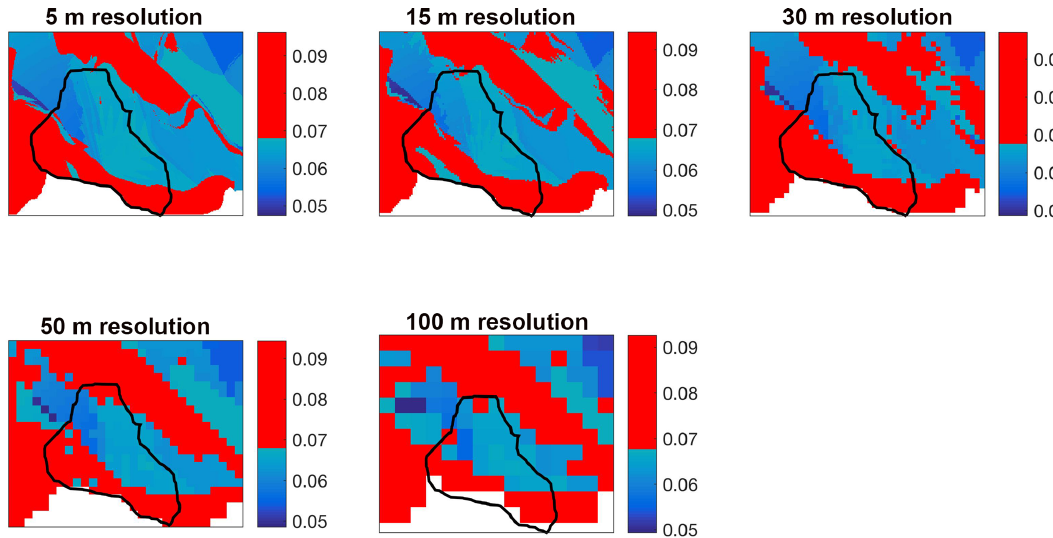
Figure 4. Maps of the percent of precipitation received as mixed precipitation at the Reynolds Mountain East subcatchment from Jan- uary 2002 to compare different spatial